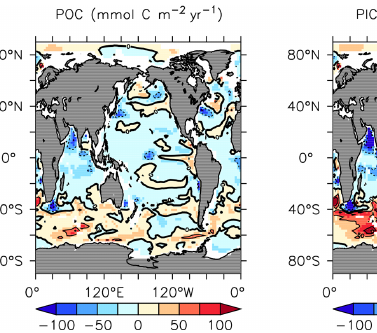
Figure 27. Modelled change in particle fluxes at 2km depth, from 2014 to 2294.